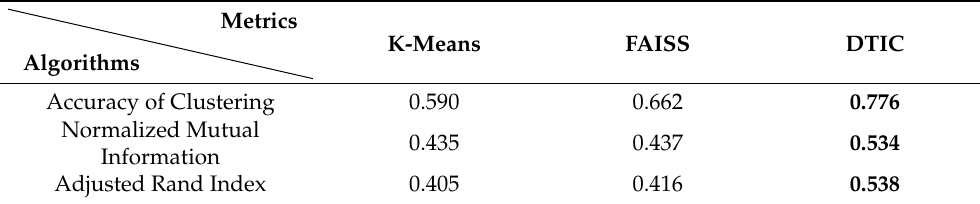
Table 3. A comparison of different methods on Reunion Island Dataset with random initial cluster centers. The bolded results show the best results.